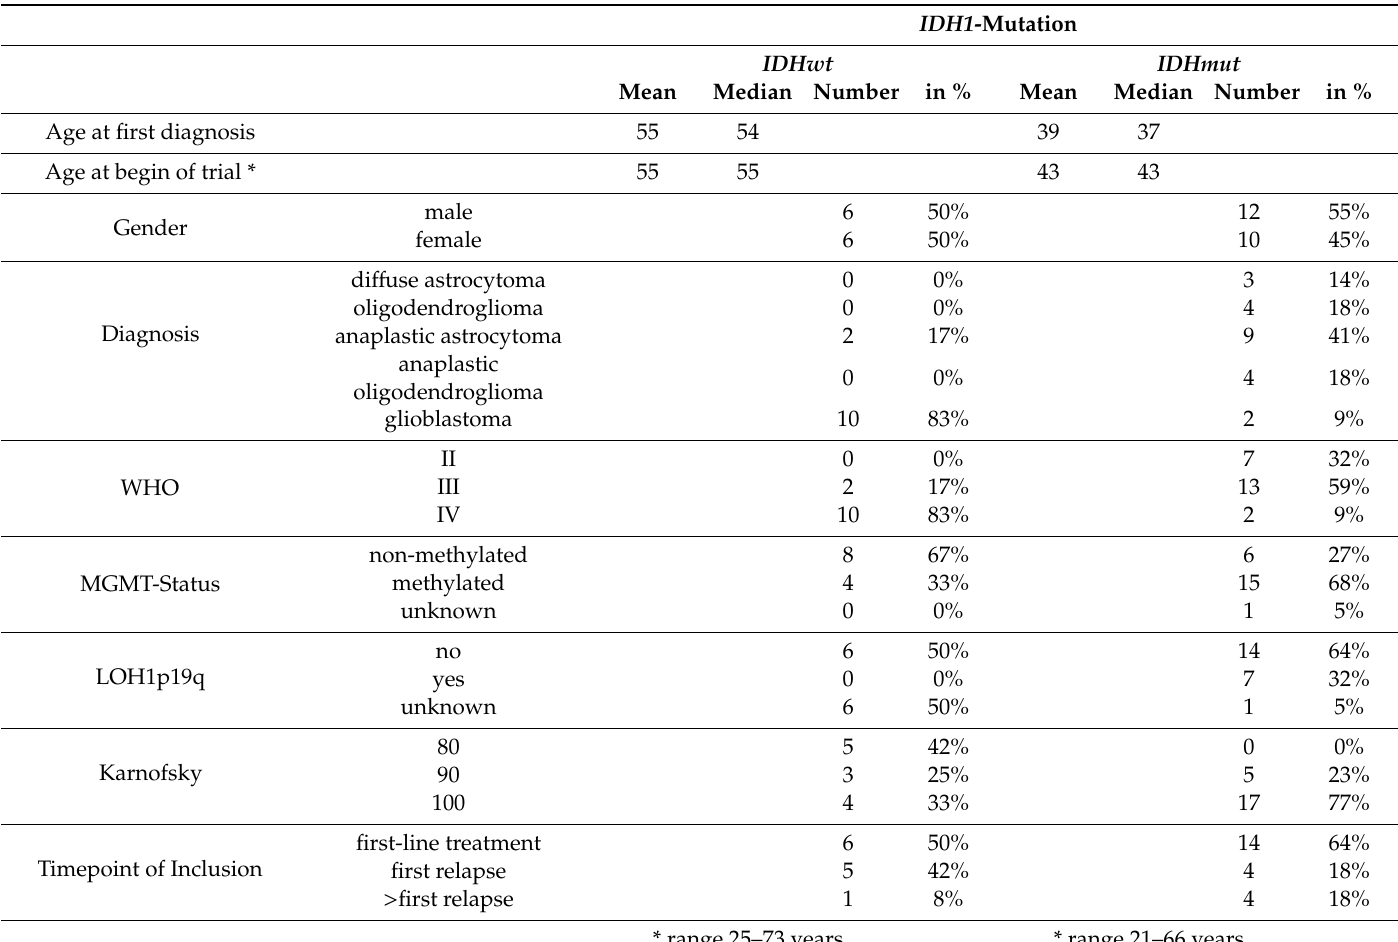
Table 1. Study patient characteristics dependent on IDH mutation